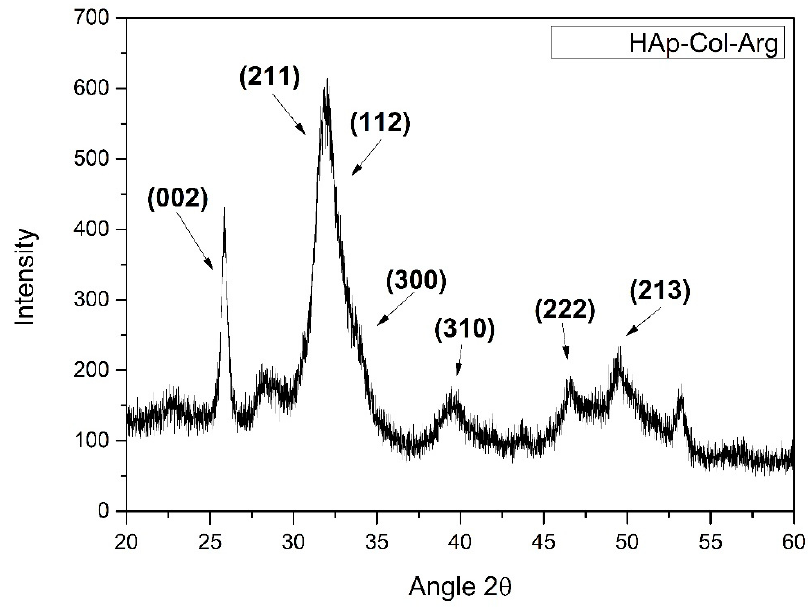
Figure 4. XRD pattern for HAp-Col-Arg samples developed through a bioinspired approach.